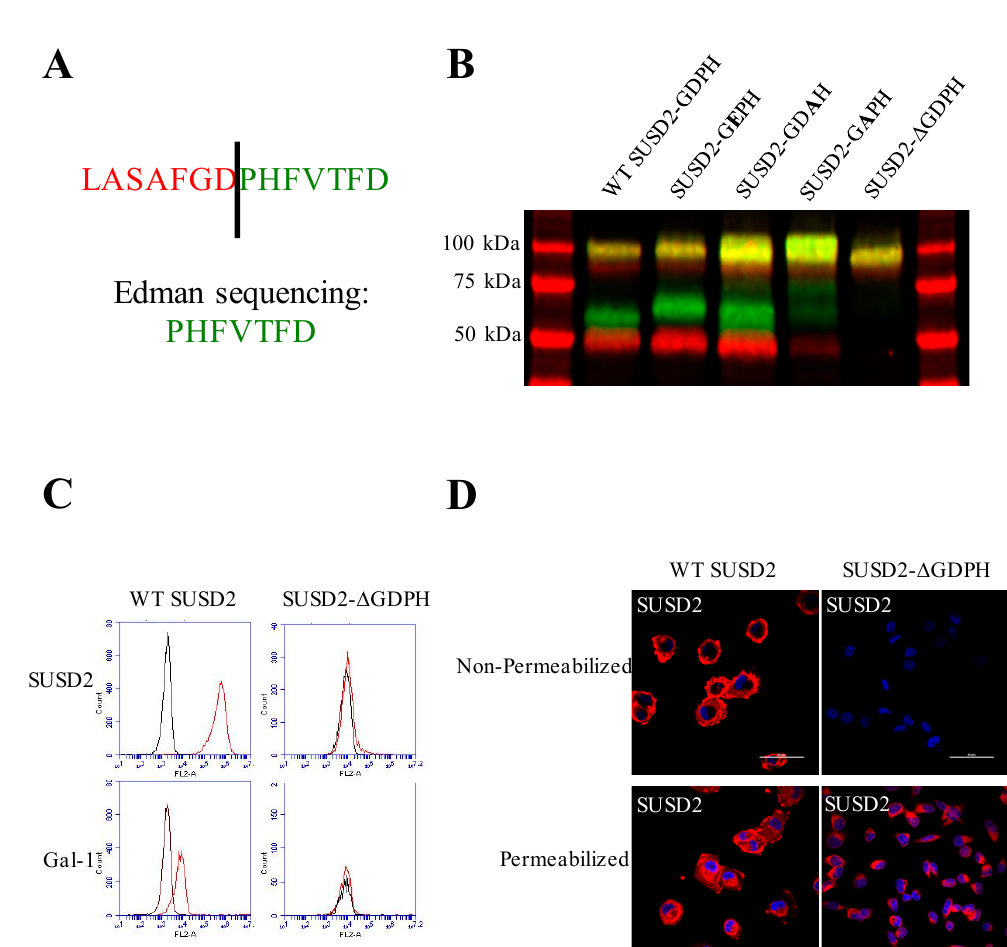
Figure 2. ( A ) SUSD2 sequence at hypothesized cleavage site (top). Edman sequencing results of C-terminal SUSD2 fragment (bottom). ( B ) Western immunoblot analysis of cell lysates generated from transiently transfected 293T cells with expression plasmids encoding WT-SUSD2, SUSD2-GEPH, SUSD2-GDAH, SUSD2-GAPH, or SUSD2- ∆ GDPH. Anti-C-terminal (green) and anti-N-terminal (red) SUSD2 antibodies were used. ( C ) E ff ect of SUSD2- ∆ GDPH deletion on SUSD2 and